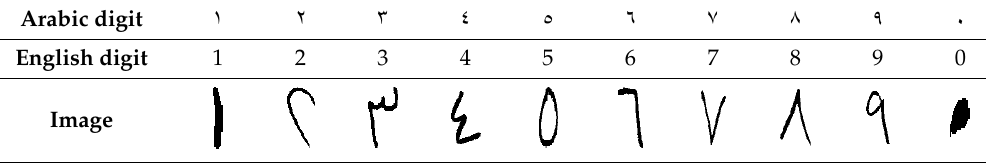
Table 3. Sample images of digits (0–9) from the ADBase database.